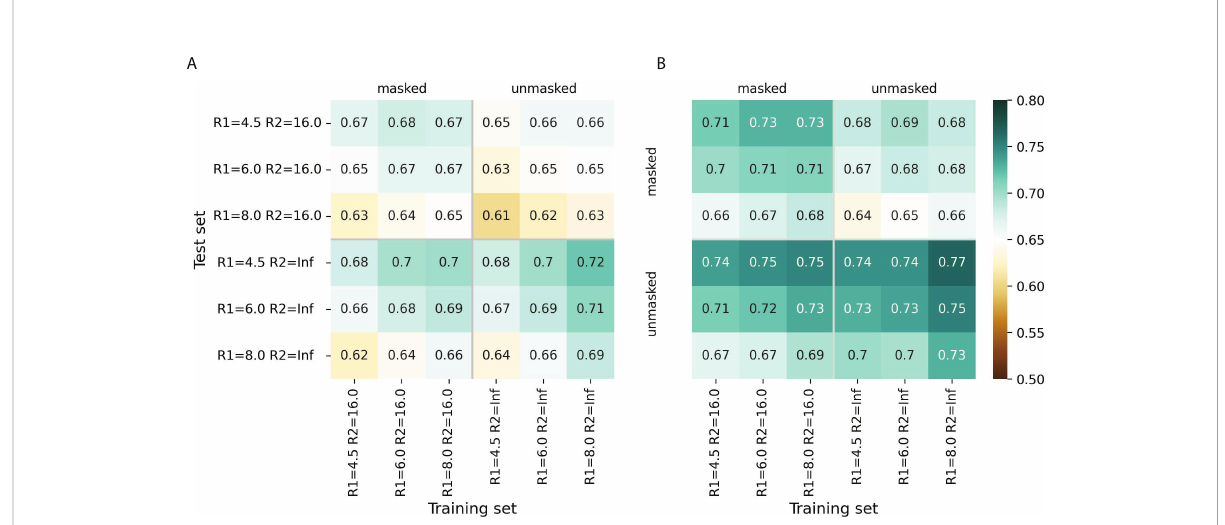
FIGURE 2 Model performance metrics estimated for the “ masked ” and “ unmasked ” test and training sets. (A) ROC AUC values for SEMA-1D. (B) ROC AUC values for SEMA-3D. The color gradient indicates the ROC AUC value from low (brown) to high